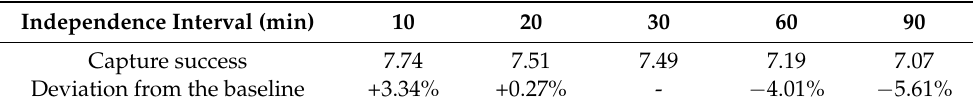
Table 3. Capture success (number of independent captures per 100 sampling days) of Bare-faced Curassow ( Crax fasciolata ) obtained in the Northern Pantanal (Mato Grosso, Brazil) from July 2015 to December 2017, based on different independence intervals (10, 20, 30, 60, and 90 min), with expressed deviations from the baseline used in this study (30 min independence interval). Independence Interval